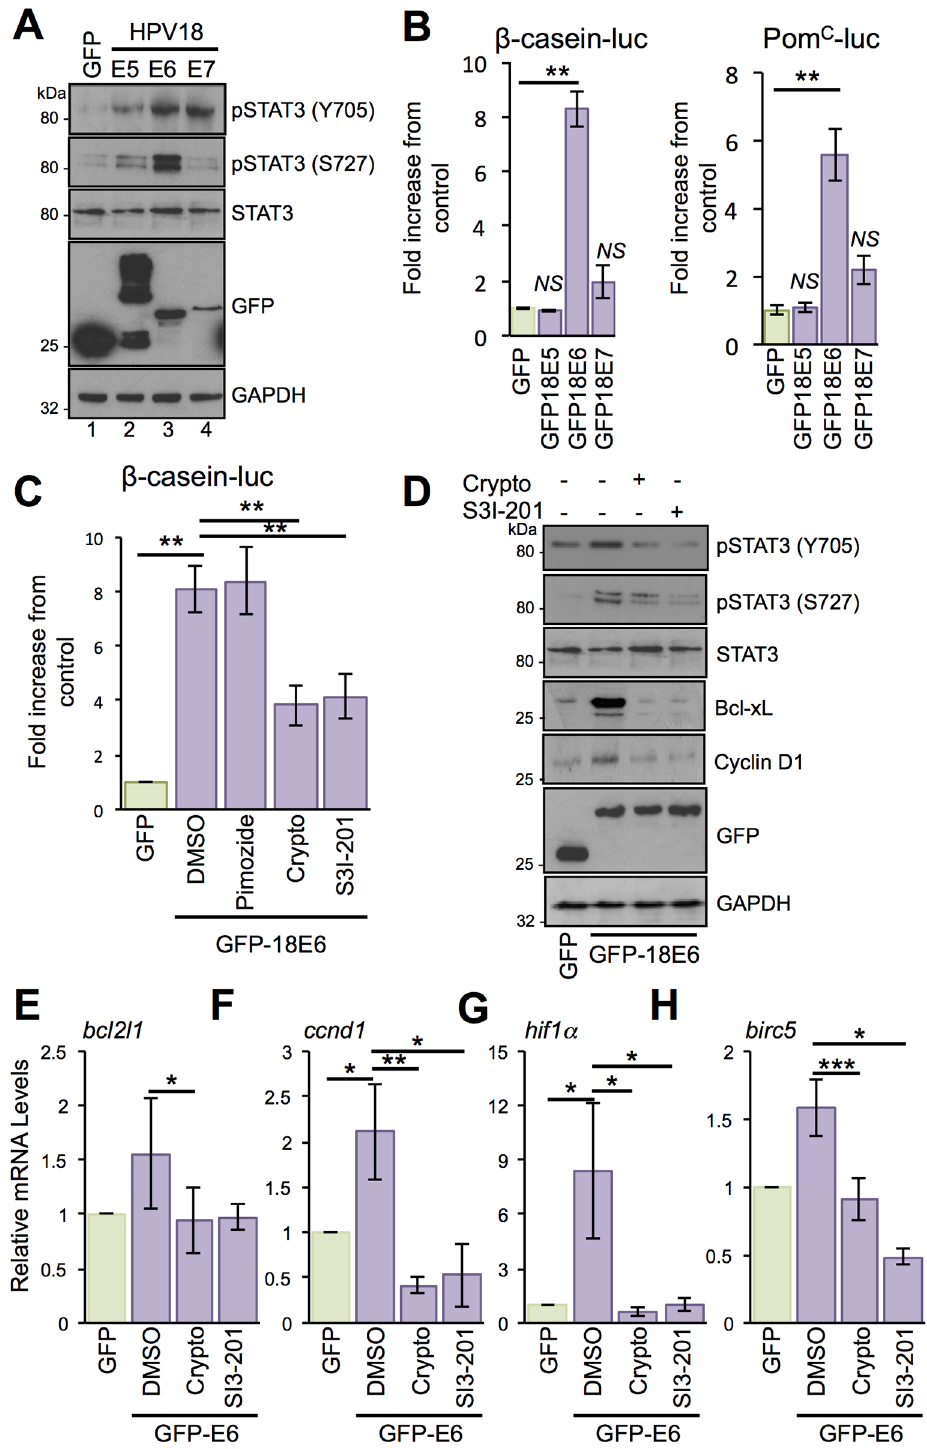
Fig 2. HPV E6 promotes the dual phosphorylation and activation of STAT3. A) Representative western blot of C33a cells transfected with GFP tagged HPV18 oncoproteins E5, E6 or E7 and analysed for STAT3 activation using specific antibodies detecting phosphorylated and total STAT3. Expression of HPV oncoproteins was confirmed using a GFP antibody. GAPDH served as a loading control. B) Representative luciferase reporter assays from C33a cells co- transfected with GFP tagged HPV18 oncoproteins E5, E6 or E7 and either a β -casein promoter reporter plasmid or